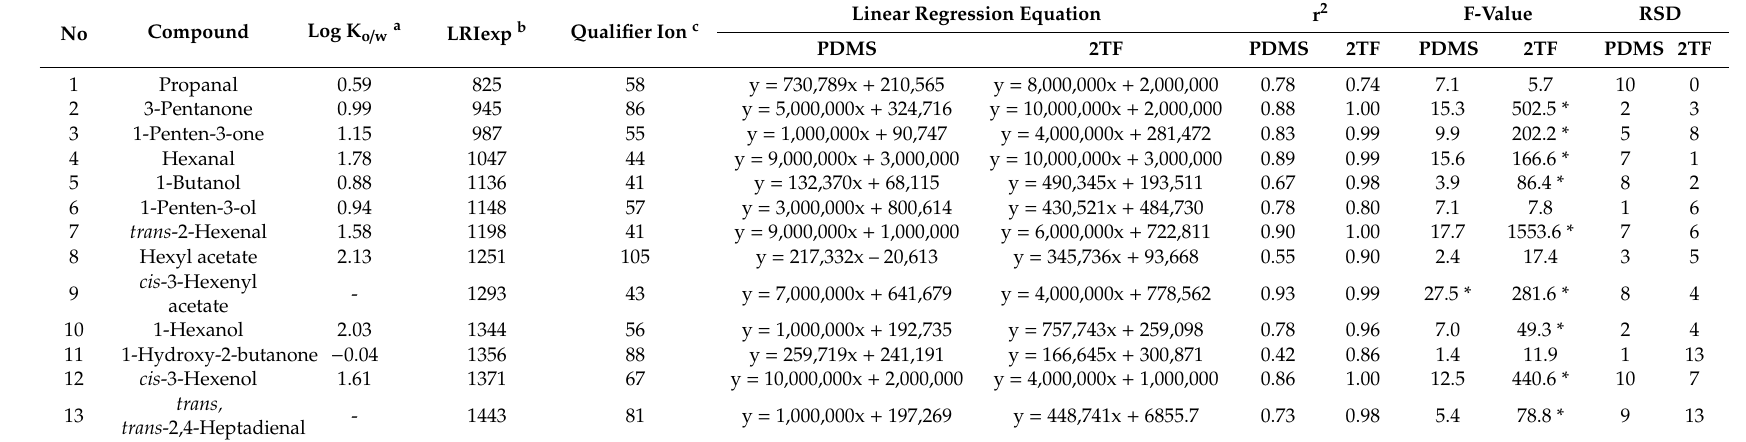
Table 2. Results of sensitivity, linearity and intermediate precision